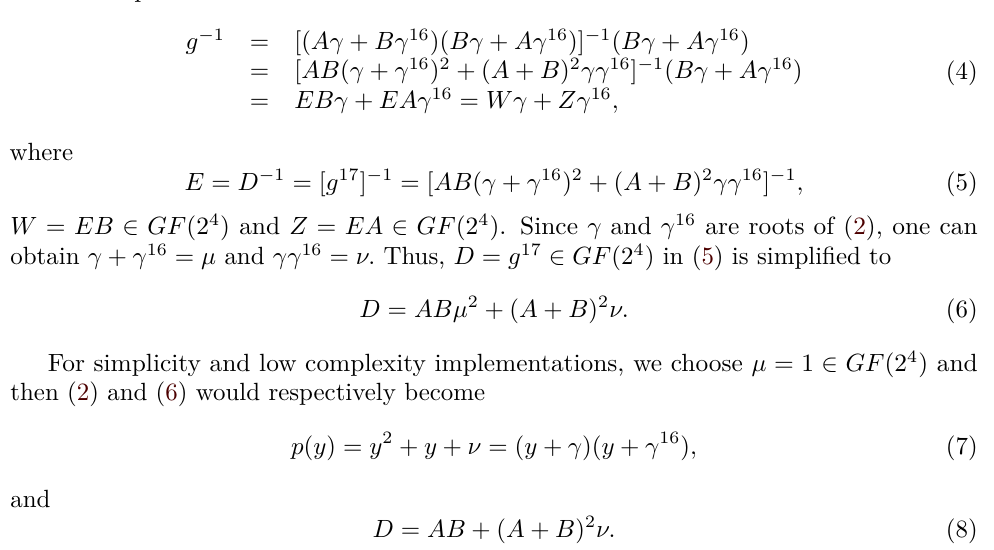
Figure 1: The architecture for GF inputs and the redundant normal basis (RNB) representation at the